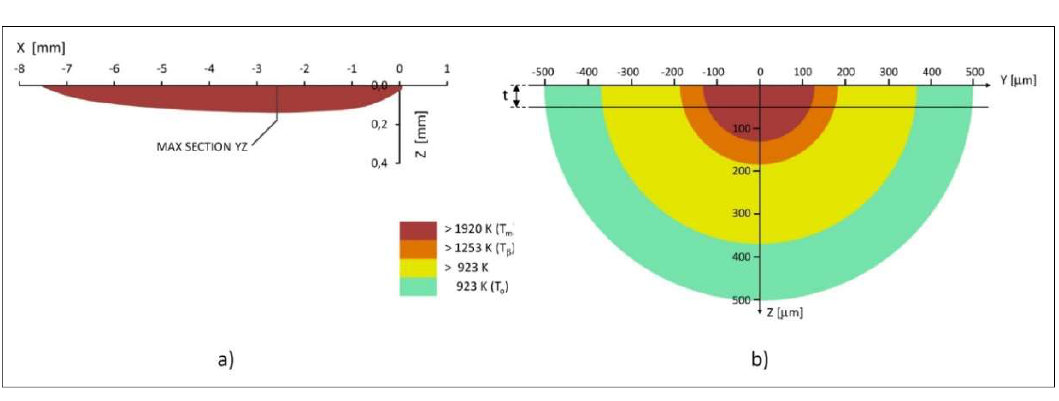
Figure 6. Thermal analysis of melt pool: ( a ) Melt pool shape in the central longitudinal plane xz ; ( b ) Temperature field of the transverse cross section at the maximum melt pool depth.